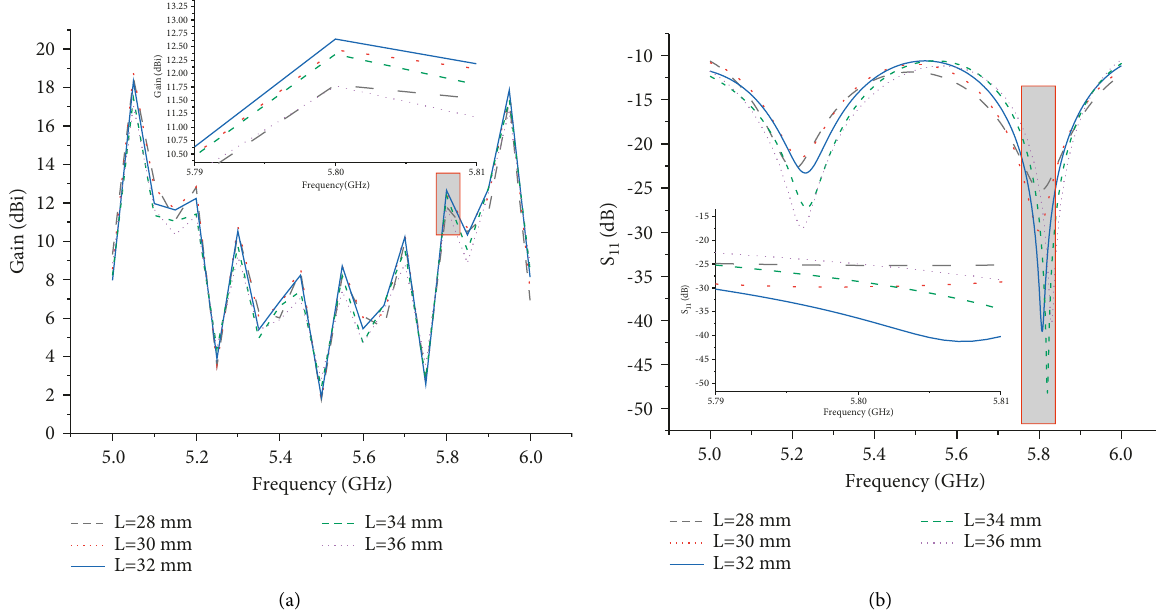
Figure 12: Frequency behavior of the gain (a) and of the magnitude of antenna S-parameter (b) for different values of the grooves curvature